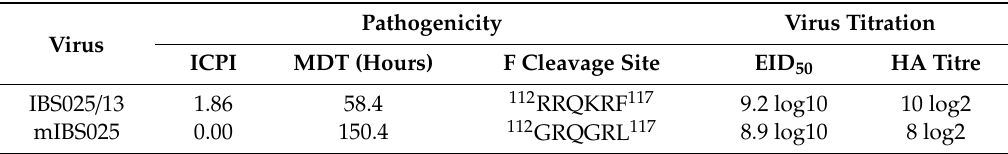
Table 2. Biological features of the parental and rescued viruses. Virus